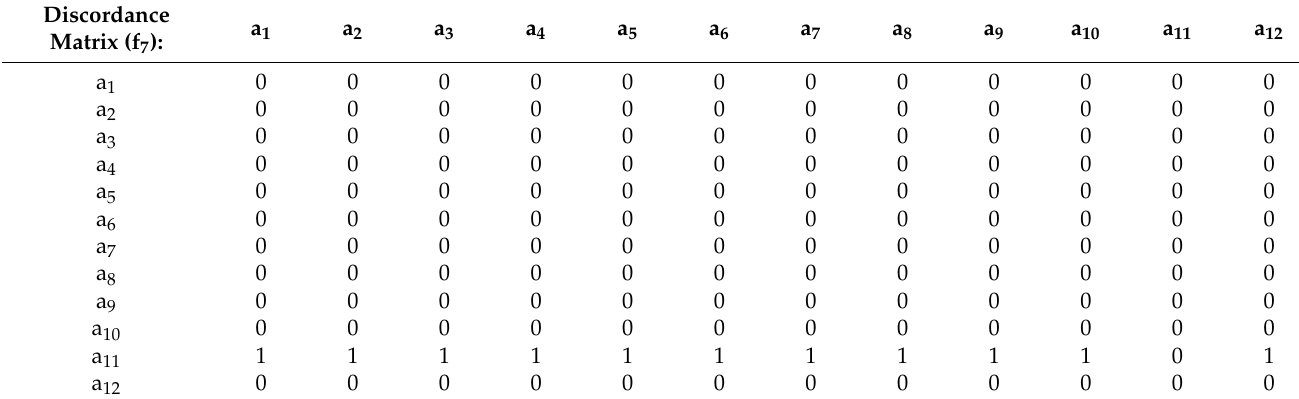
Table A7. Values of the non-compliance indicators according to the 7th criterion.